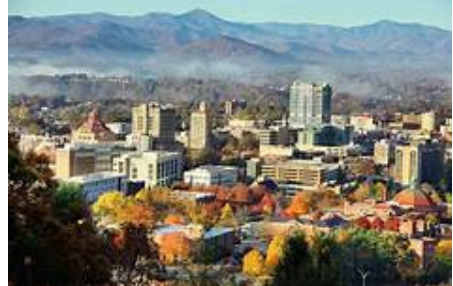
Figure 4. Asheville, NC.